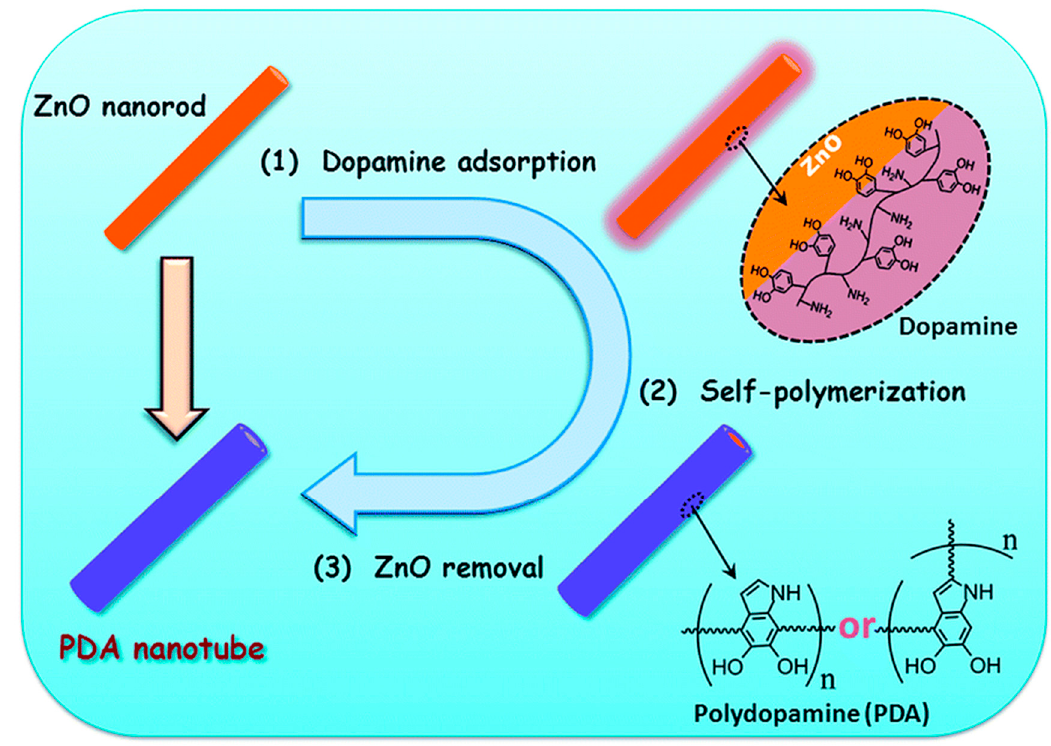
Figure 1. Roadmap of the synthesis procedure of PDA nanotubes [83] . (Copyright (2016) Royal Society of Chemistry).